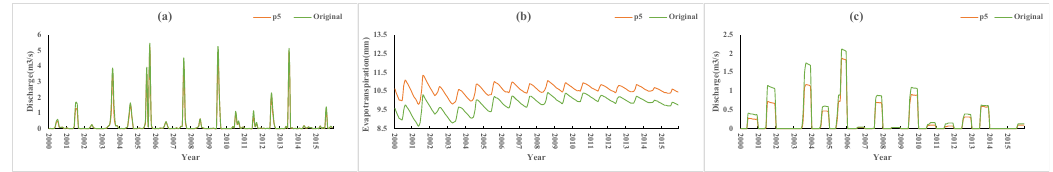
Figure 14. P5 vs. Original simulation results: ( a ) surface runoff, ( b ) evapotranspiration, ( c ) farmland